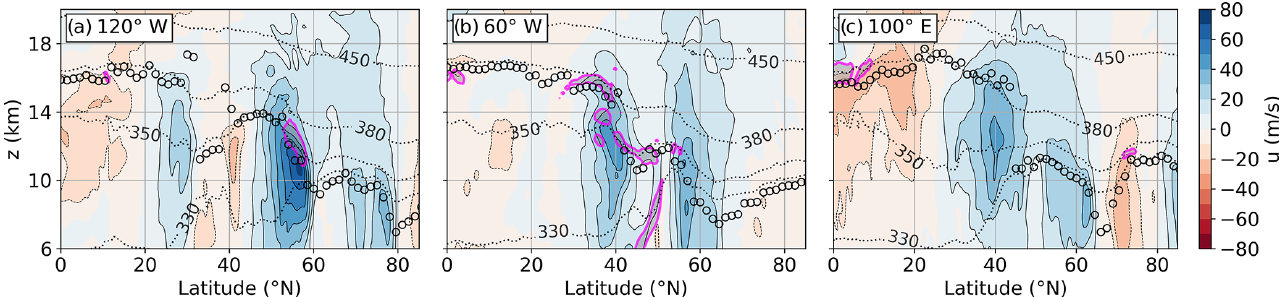
Figure 3. Vertical cross sections on 11 September 2017 at 00:00UTC at (a) 120 ◦ W, (b) 60 ◦ W, and (c) 100 ◦ E. Color contour shows zonal wind speed ( u , in ms − 1 ), black dots LRT altitude, and dotted black lines isentropes ( (cid:50) , in K). Magenta lines show S 2 = S 2 t isolines.